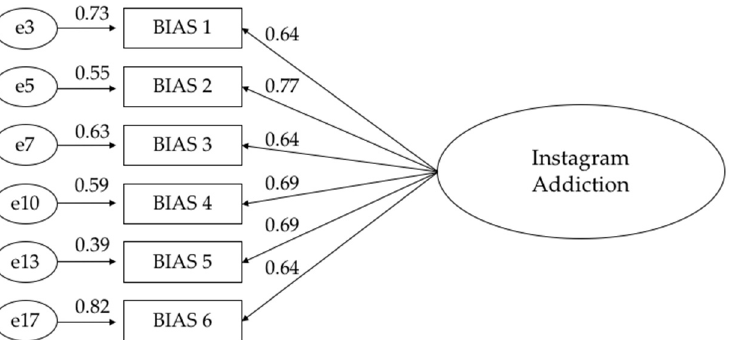
Figure 1. Factor structure and standardized loadings of items in the Bergen Instagram Addiction Scale (BIAS). Scale